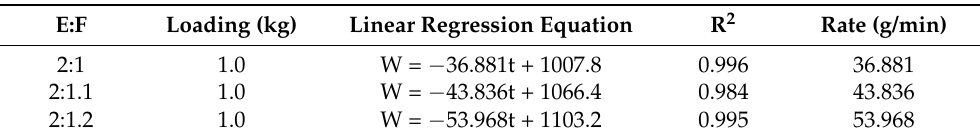
Table 2. Drying rate of wild bitter gourd extract (E) mixed with soybean fiber powder (F) by 10 kW radio frequency heating.